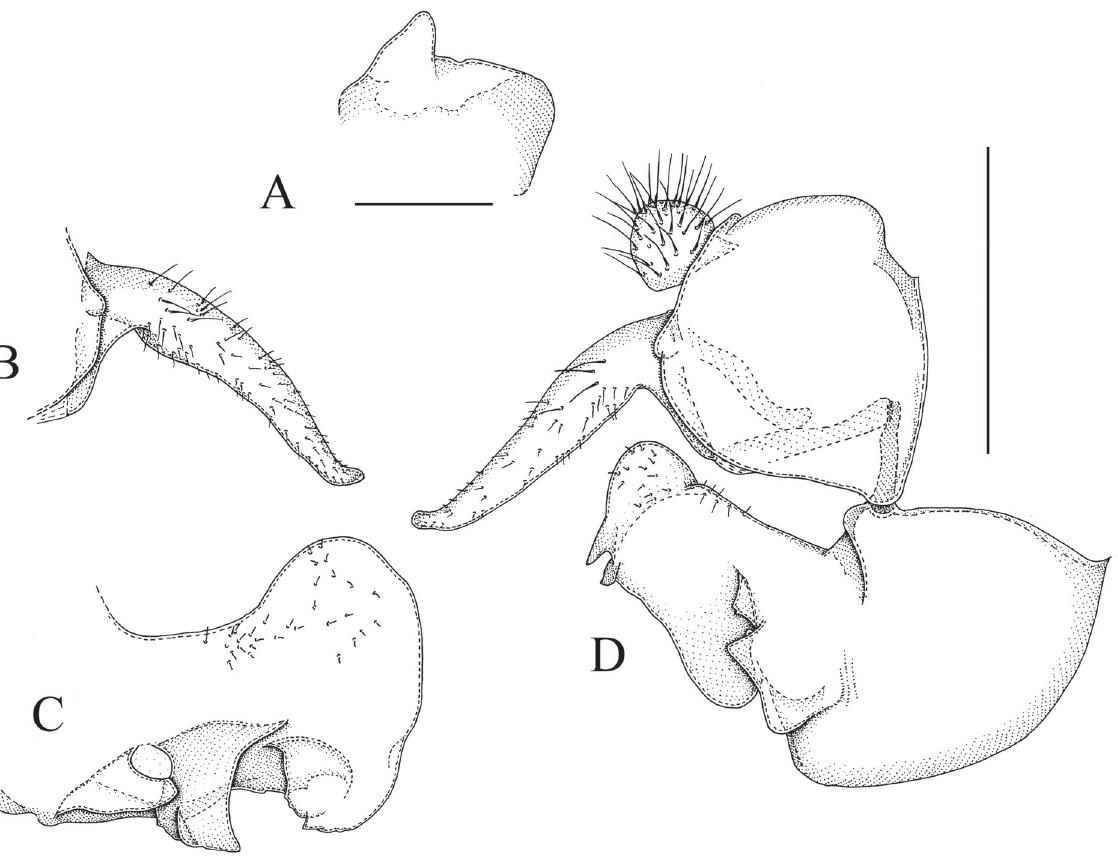
Fig. 7. Sphegina (Asi osphegina) albolobata sp. nov., holotype, ♂ . A . Posterior part of sternum IV, ventral view. B . Left surstylus, lateral view. C . Left superior lobe, lateral view. D . Genitalia, right side, lateral view. Scale bars = 0.5